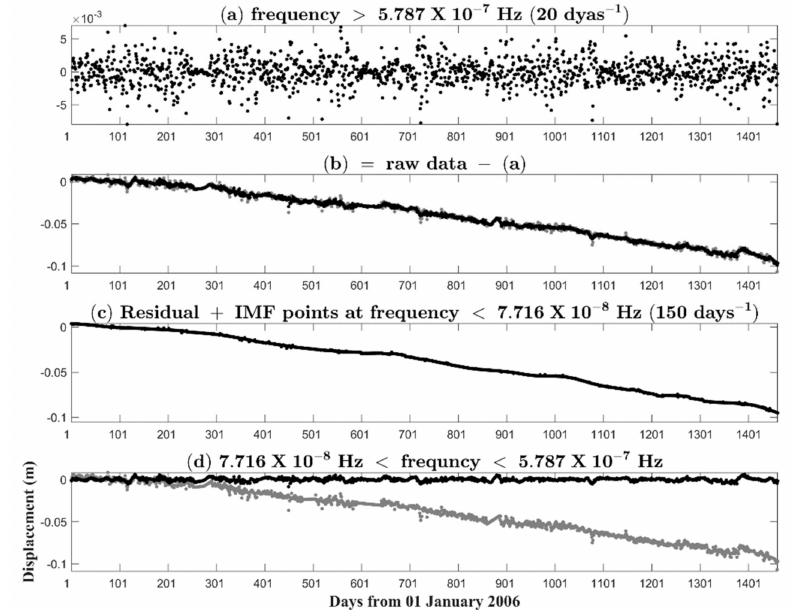
Figure 4. The filtered deformation derived by the band pass filter for HUAL station. ( a ) exhibits the noise computed by using a high-pass filter of a frequency > 5.787 × 10 − 7 Hz. ( b ) shows the noise-free data. ( c ) reveals the variations of the long-term e ff ects. ( d ) is the filtered displacements using a band-pass filter of a frequency band between 7.716 × 10 − 8 Hz and 5.787 × 10 − 7 Hz. The grey lines in (b) and (d) show the raw